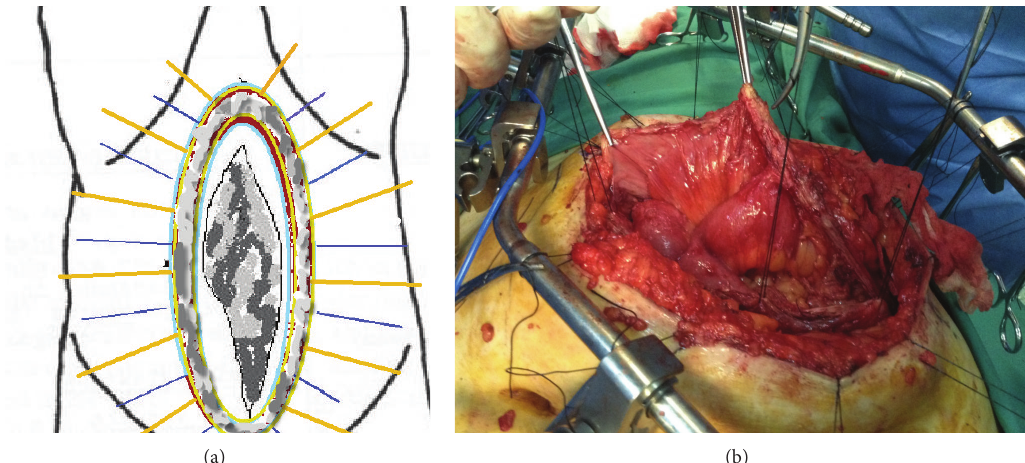
Figure 4: Third row of suspension threads was placed on the peritoneum, providing wide exposure of the peritoneal cavity. Isolation of the abdominal viscera involved in “frozen